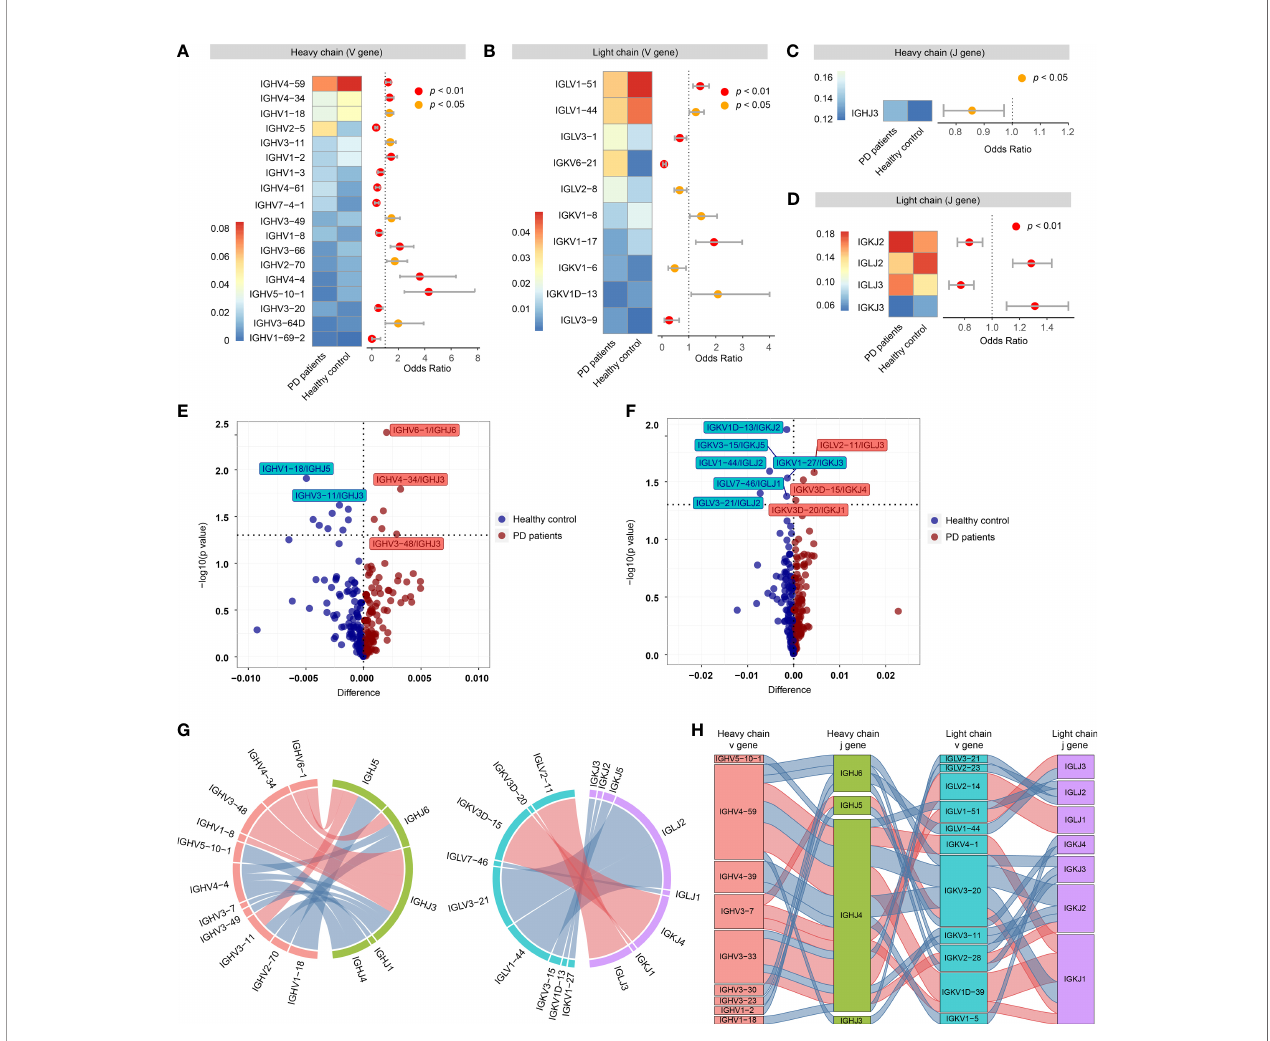
FIGURE 3 | Preferential variable (V) and joining (J) gene segments in the heavy and light chain of BCRs in PD patients. (A) Differential usage (Fisher ’ s exact test) of V H gene segments between PD patients and healthy controls. (B) Similar to A, differential usage of V L gene segments. (C) Similar to A, differential usage of J H gene segments. (D) Similar to A, differential usage of J L gene segments. (E) Volcano plot shows the signi fi cant different frequency of heavy chain VJ pairs of PD patients compared to healthy controls. (F) Similar to E, volcano plot shows the signi fi cant different frequency of light chain VJ pairs. (G) Circos plots show the differential heavy (left) and light (right) VJ pairs in PD patients and healthy controls. Red links represent PD speci fi c VJ pairs, and blue links represent healthy control speci fi c VJ pairs. (H) Sankey diagram shows signi fi cant different frequency of heavy-light VJ pairs in PD patients and healthy controls. Red links represent PD speci fi c pairs, and blue links represent healthy control speci fi c